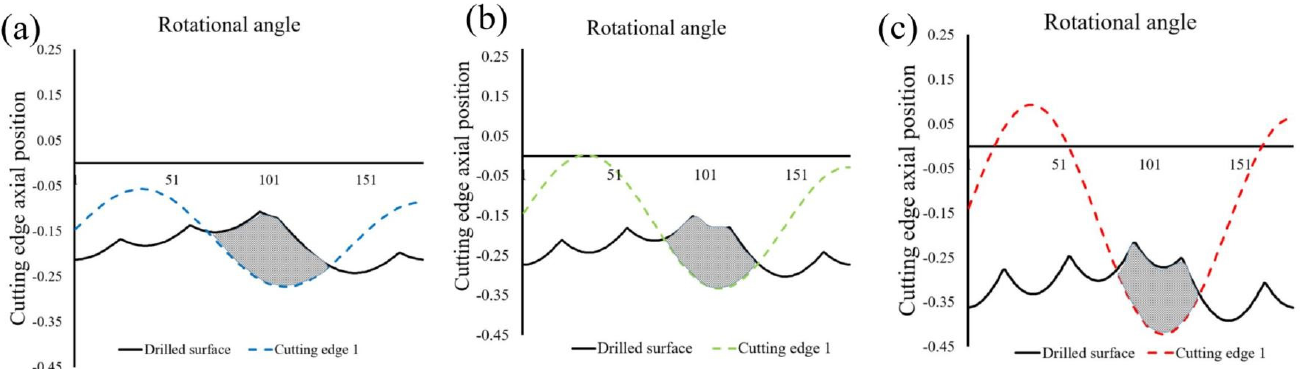
Figure 2. Effect of vibration amplitude on the uncut chip formation at ( a ) A m = 0.1 mm, ( b ) A m = 0.16 mm, and ( c ) A m = 0.25 mm .